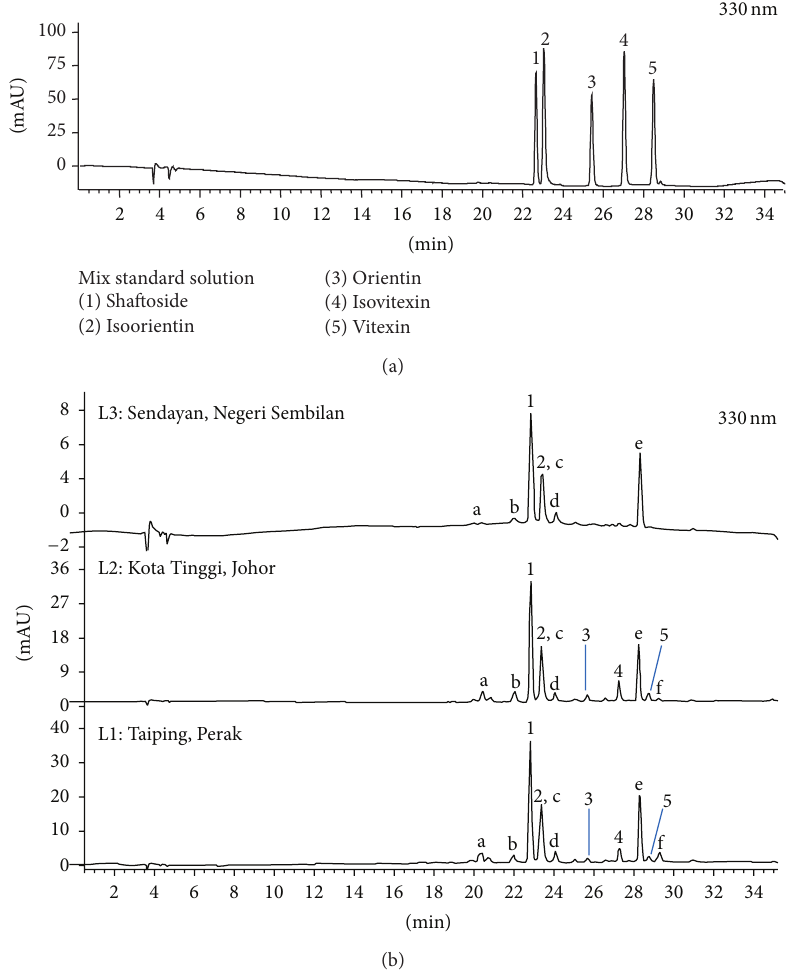
Figure 3: HPLC-UV/DAD chromatogram of (a) standard solution mixture and (b) ethanolic extracts of C. nutans leaves, 𝜆 = 330 nm. C. nutans samples L1: Taiping, Perak, L2: Kota Tinggi, Johor, and L3: Sendayan, Negeri Sembilan. (1) Shaftoside, (2) isoorientin, (3) orientin, (4) vitexin, and (5) isovitexin, a–f.